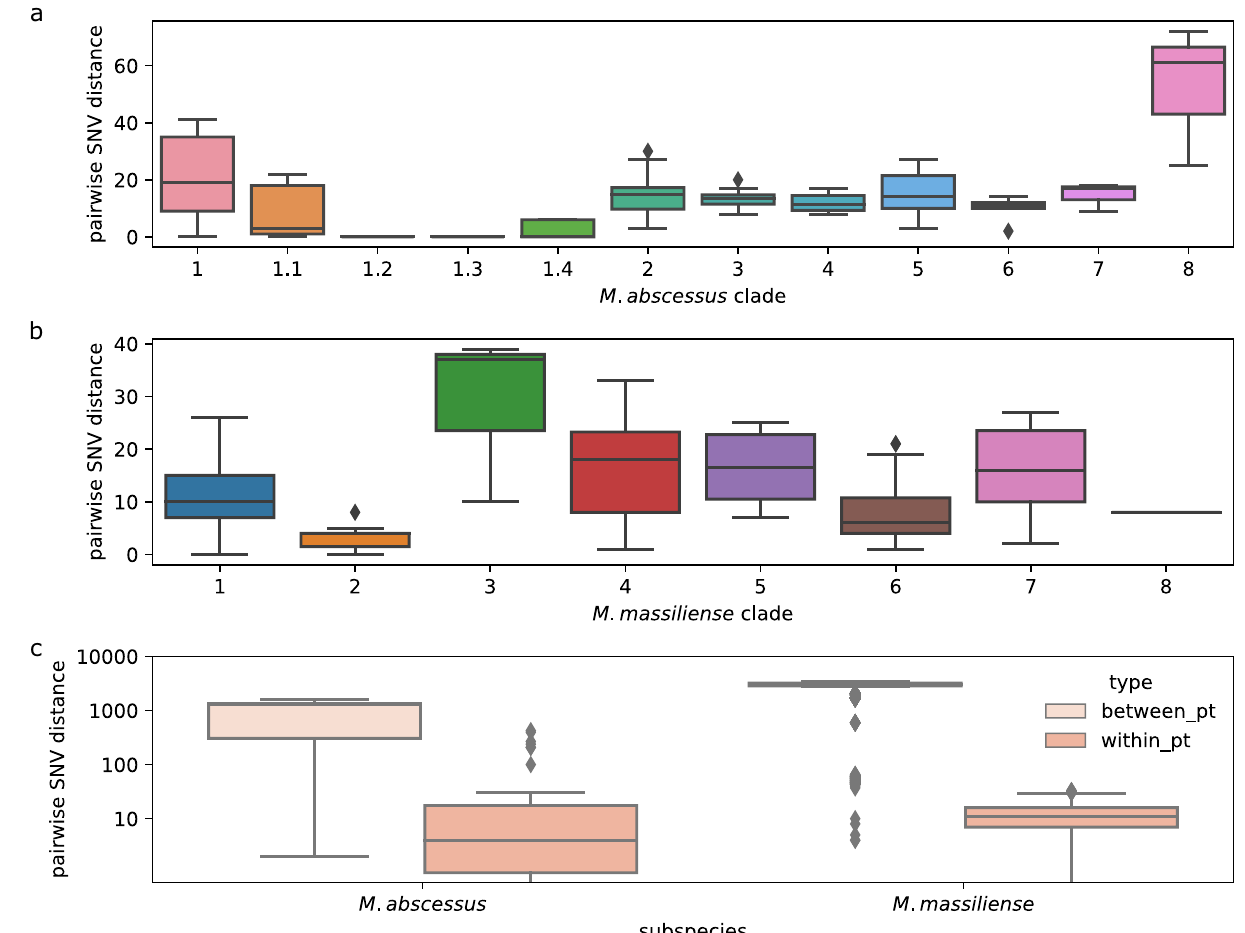
Figure 3. Summary of pairwise SNV distances. Recombination-masked SNV distances for the indicated clades were computed for each subspecies and clade in Fig. 2. Lines and boxes indicate the median and interquartile range (IQR), while whiskers extend to 1.5 × the IQR. Colours match the indicated clades in the Fig. 2. Where missing, median lines coincide with upper quartiles. ( a ) M. abscessus. ( b ) M. massiliense . c Within- and Between-patient pairwise SNV distances by